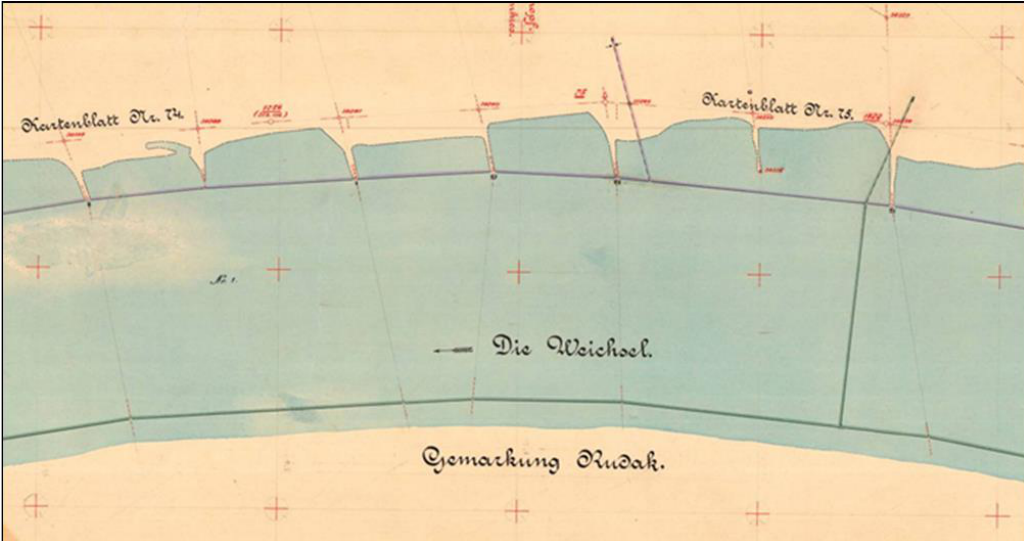
Figure 9. A fragment of the cadastral map of Toruń showing the northern bank of the Vistula River (German: Die Weichsel). Source: Gemarkungskarte der Stadt Thorn, Blatt 154, State Archives in Toruń.